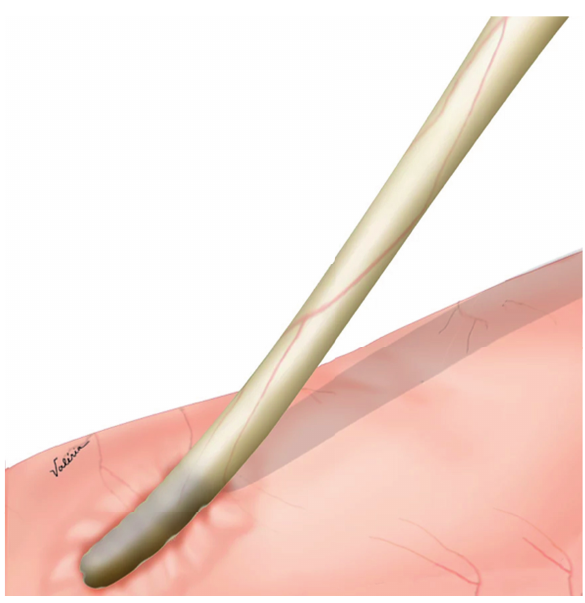
figure 1 - Ureter mobilization.